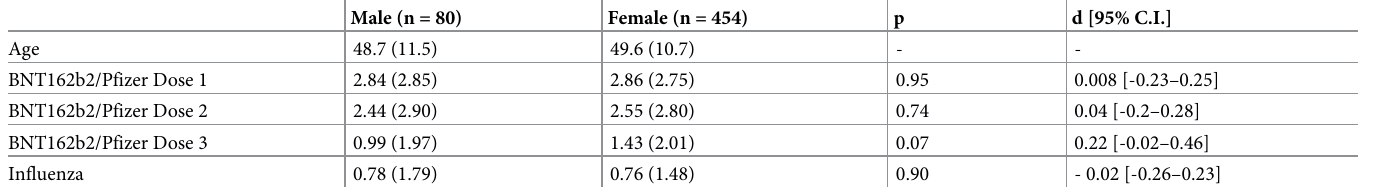
Table 1. Number of AEs by participant gender and vaccine dose: Mean (S.D) number of AEs reported by male versus female HCWs for all three BNT162b2/Pfizer doses and the seasonal Influenza vaccine. Male (n = 80) Female (n = 454) p d [95% C.I.]